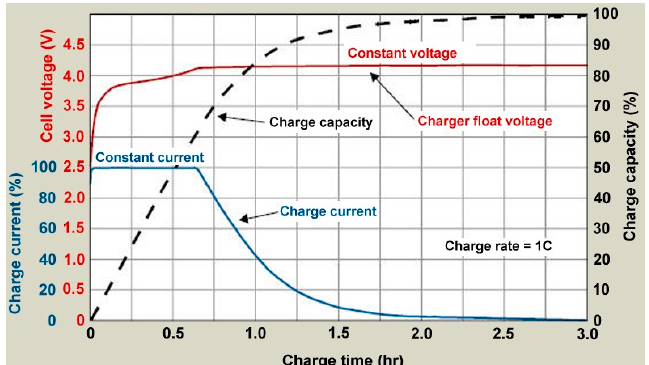
Figure 6. Example Constant Current, Constant Voltage (CC-CV) battery charging approaches [106].